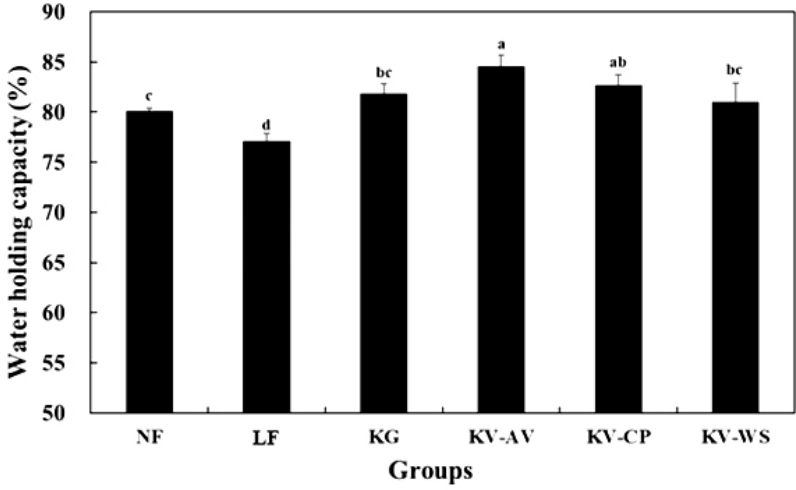
Figure 1. Water holding capacity of frankfurter sausages. Groups of frankfurter sausage: NF, normal-fat frankfurter sausage formulated with 20% ice and 20% fat; LF, low- fat frankfurter sausage formulated with 30% ice and 10% back fat; KG, frankfurter sausage formulated with 10% konjac gel and 10% back fat; KV-AV, frankfurter sausage formulated with 10% konjac gel with aloe vera vegetable powder and 10% back fat; KV-CP, frankfurter sausage formulated with 10% konjac gel with cactus pear vegetable powder and 10% back fat; KV-WS, frankfurter sausage formulated with 10% konjac gel with wheat sprout vegetable powder and 10% back fat. a-d Means in the treatments with different letters are significantly different (p<0.05).